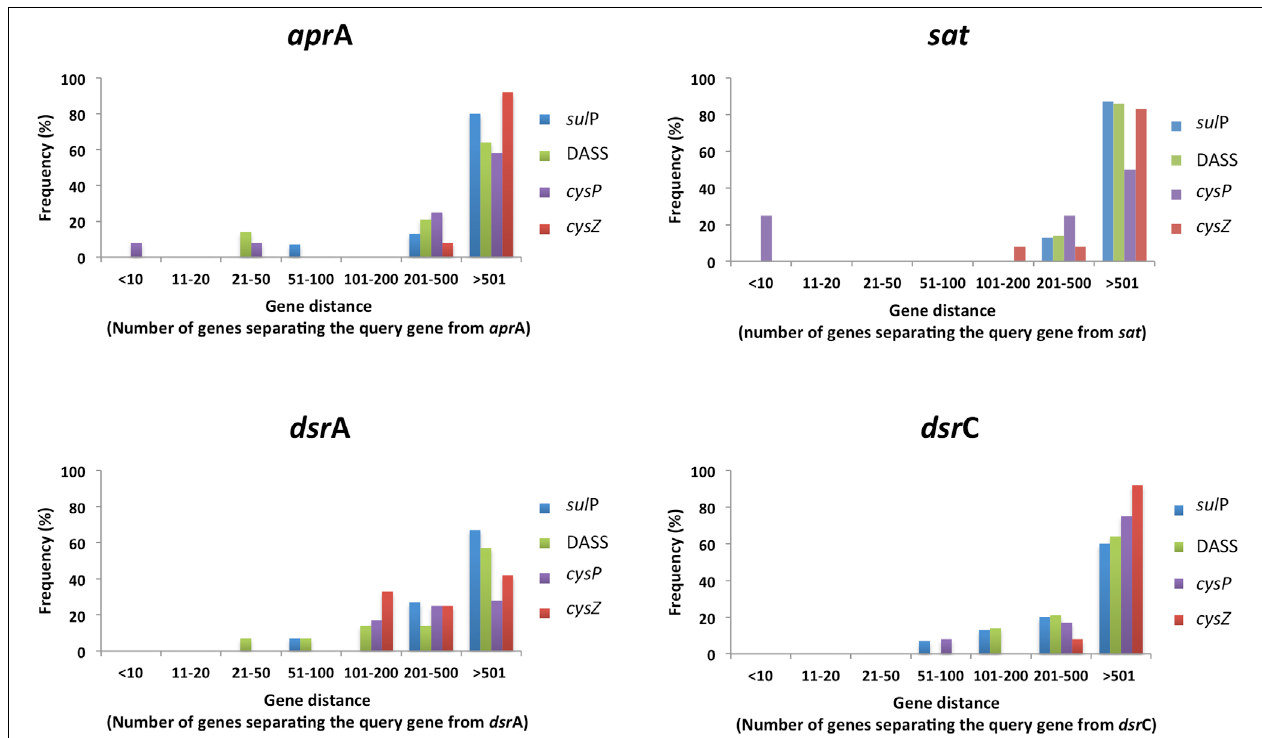
FIGURE 8 | The location of selected putative sulfate transporter genes in relation to genes involved in the sulfate reduction pathway in the examined SRM genomes. Distance was calculated using the locus tag numbers and assumed to correspond to genes away from query. Frequency was calculated as the percentage of putative sulfate tranposrters of a given protein family located a certain number of genes away from the query. The selected putative sulfate genes clustered with the model family protein with at least 50% bootstrap clade support.